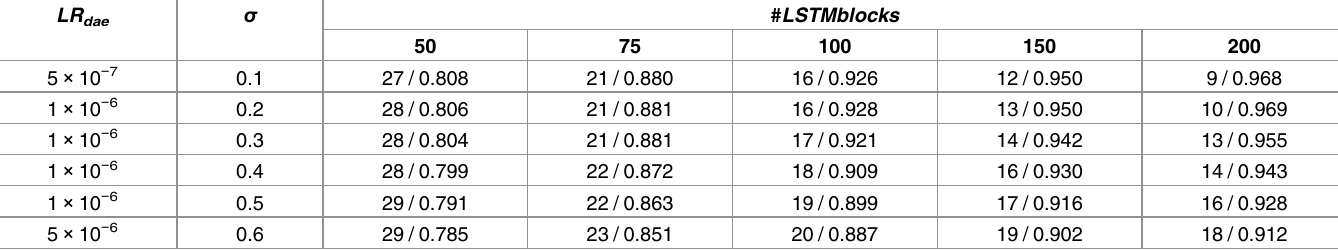
Table 5. DAE performance for different hidden layer sizes, and various variancesof the Gaussian noise σ applied to the inputs during training. For each combination of σ and # LSTMblocks , we indicate the mean-squared error rmse and Person’s linear correlationcoefficient r ( rmse / r for each cell). LR